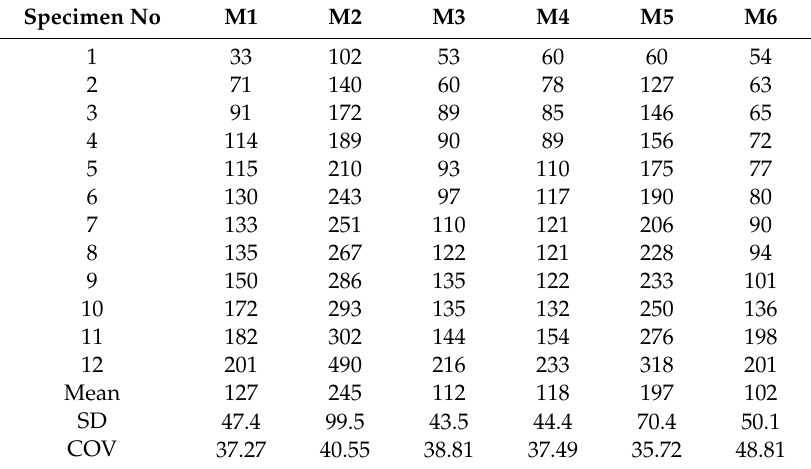
Table 3. Number of impacts taken to cause cracking for the six UHPFRC